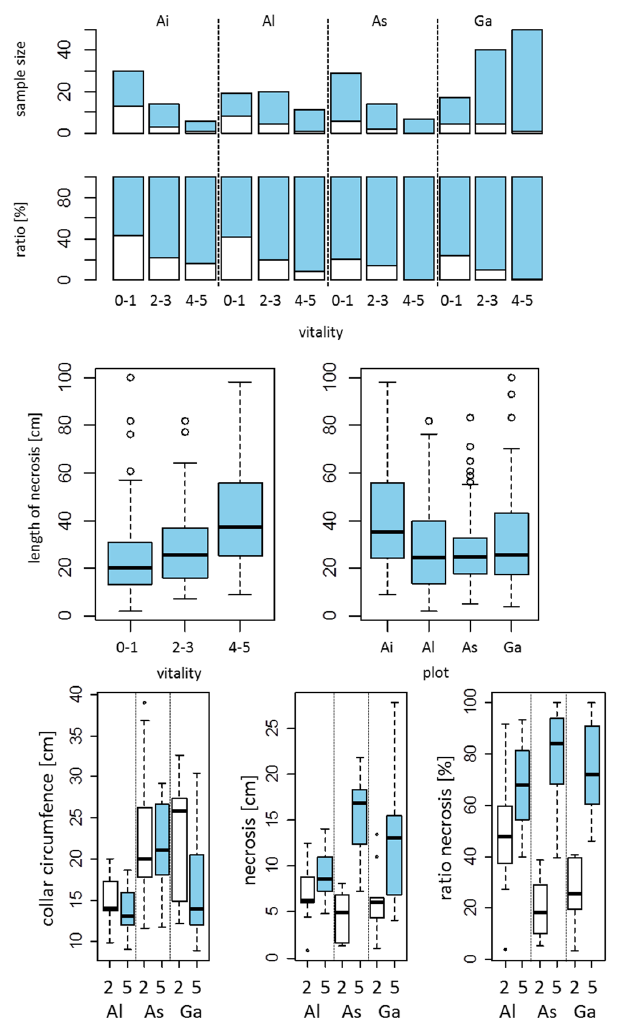
Figure 4. Sample size and ratio of trees with Armillaria infestation (top row, blue) and without an infestation (white) are shown for four stands in 2013 (Ai–Aidenbach, Al–Albersdorf, As–Aschheim, Ga–Gaden, see Figure 1). The boxplots (middle row) show the length of stem necroses in relation to the vitality classes ( left ) and stands ( right ). Differences between vitality classes are statistically significant (two way ANOVA, vitality class: Df = 1, F = 28.9, p < 0.001, see text). The boxplots (bottom row) show the collar circumference of trees ( left ), the affected collar circumference by necroses ( middle ) and the ratio necroses/collar circumference of trees of the vitality class 2 (white) and 5 (blue) with 10 trees per vitality class. Differences between the vitality classes 2 and 5 in all three plots are statistically significant.